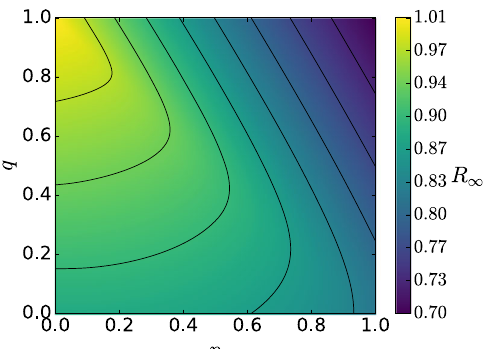
Fig. 5 Variation of distillation bounds with Hamiltonian. We illustrate variation of the bound in Eq. 40 with respect to the system Hamiltonian. We fi x ð ϵ ; ϵ 0 ; β Þ ¼ ð 0 : 1 ; 0 : 0 ; 0 : 2 Þ and look at a family of Hamiltonians for the qutrit systems, given by H = A 0